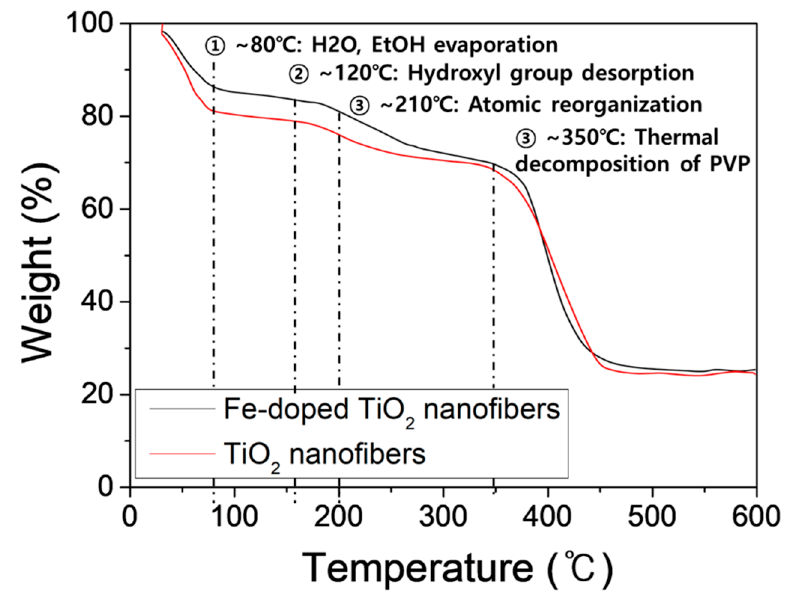
Figure 1. TGA curves of Fe-doped TiO 2 nanofibers and TiO 2 nanofibers